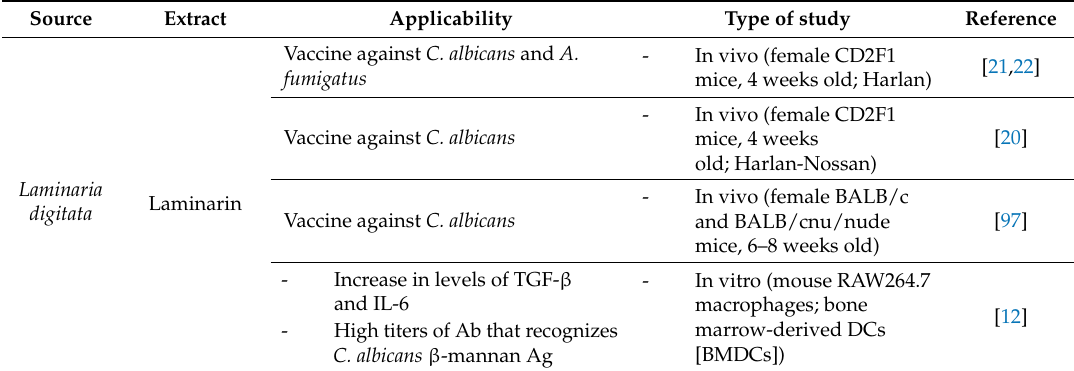
Table 3. Applicability of β -glucans from seaweed of the genus Laminaria spp. in vaccines against different pathogenic